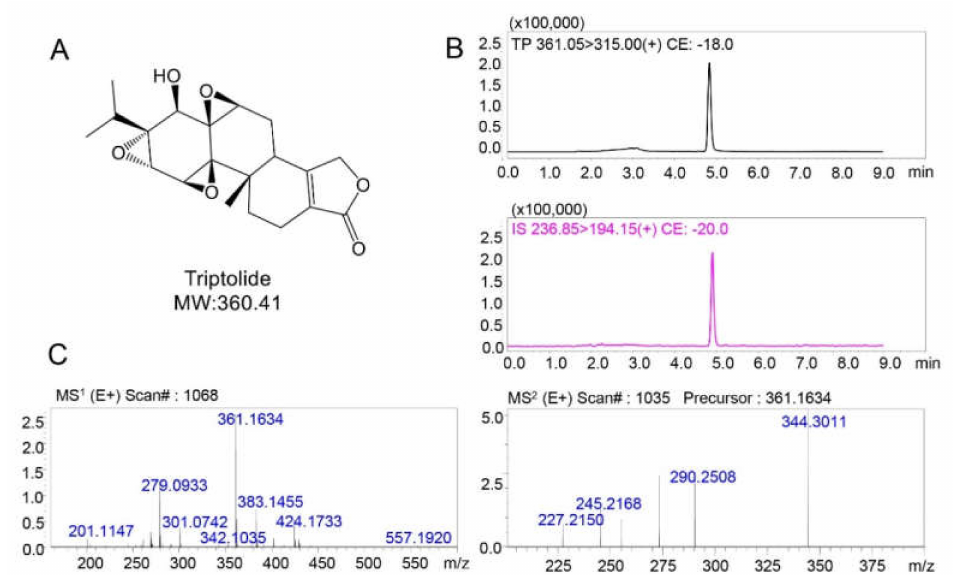
Figure 1. The structure and mass spectra of triptolide. ( A ) The structural formula of triptolide. ( B ) Extracted ion chromatogram (EIC) spectra of triptolide and the internal standard (internal standard (IS), carbamazepine). ( C ) The MS 1 and MS 2 mass spectra of triptolide acquired by LC / MS n -IT-TOF.